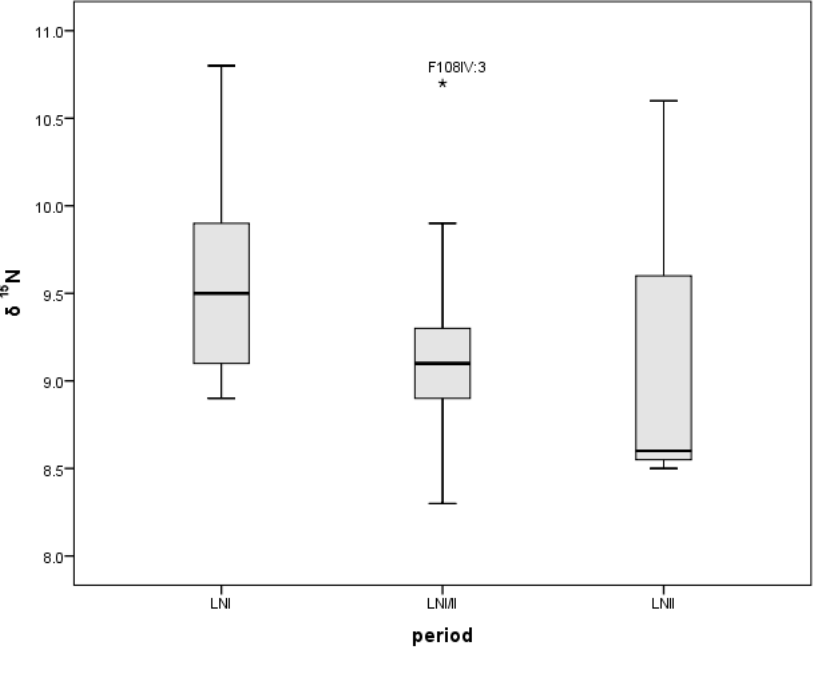
Figure 10. δ 15 N values in collagen from the seventeen individuals in Falköping stad 5, included in the diet investigation. Boxplot with line: median, box: 25 th - 75 th percentile, whisker: ca 95% of the data. LNI: Late Neolithic I, LNII: Late Neolithic